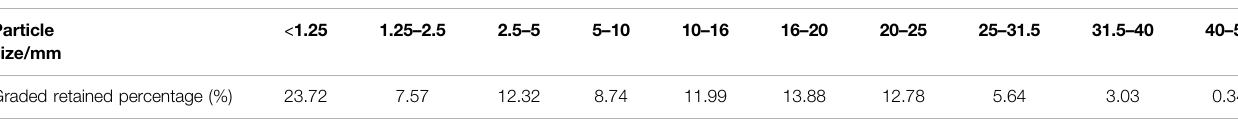
TABLE 7 | Mixed gangue gradation table.